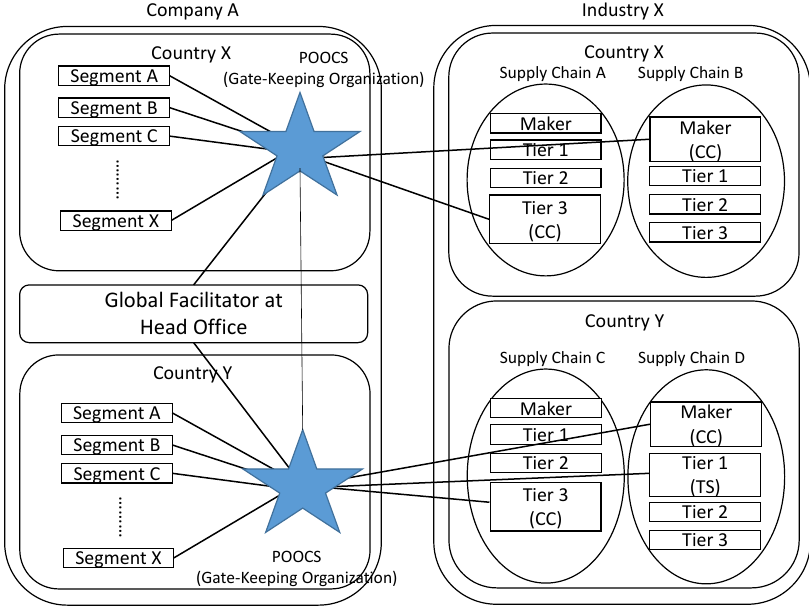
Figure 1. POOCS in the supplier